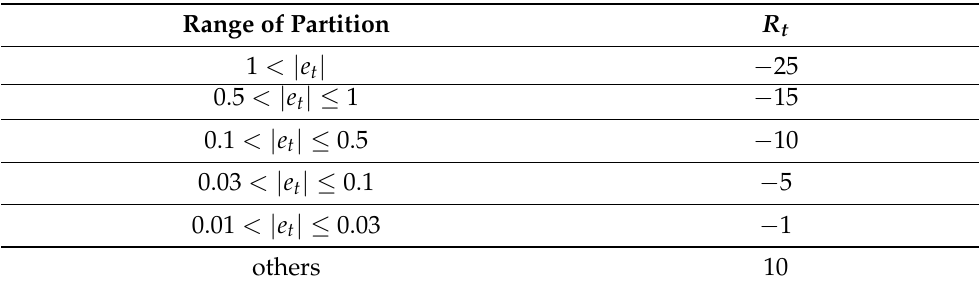
Table 1. Range of partition error and corresponding reward R t